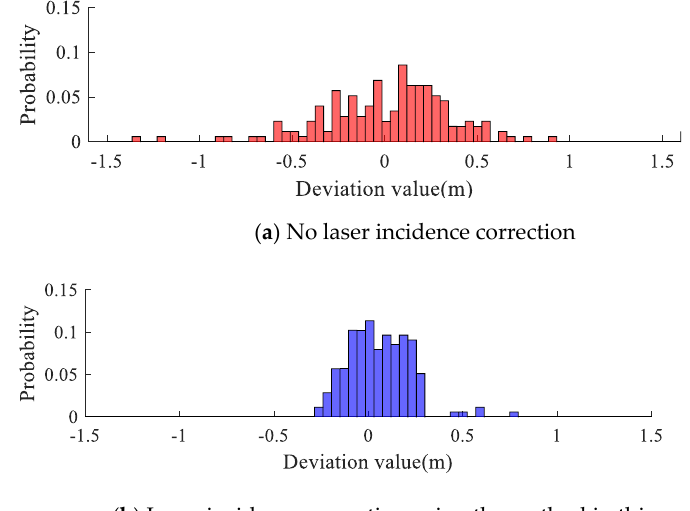
Figure 21. Probability distribution of depth deviation before water surface deviation correction vs. single-beam depth data in Experimental Area A.